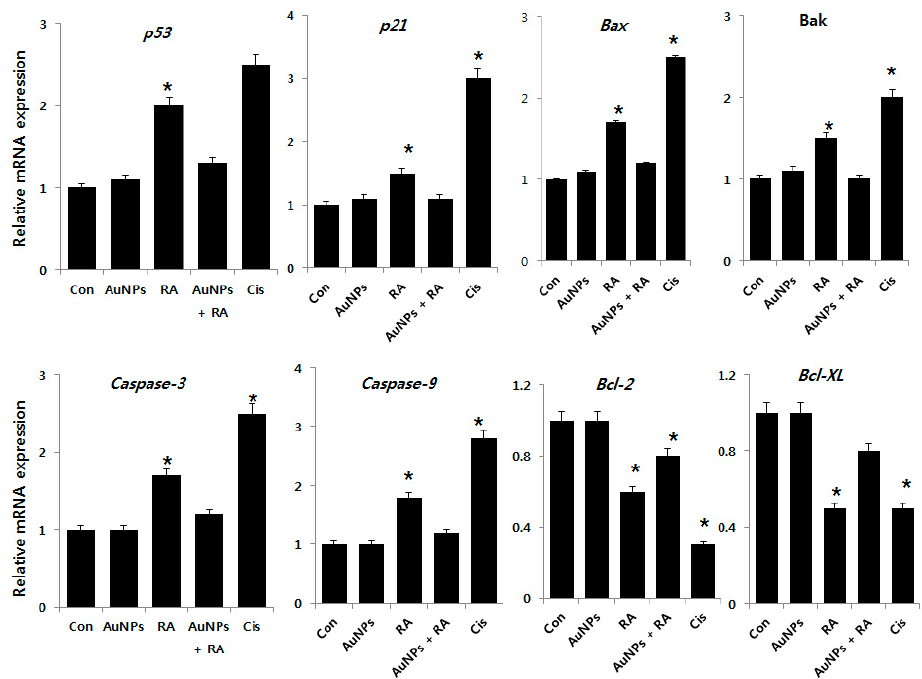
Figure 8. Effect of AuNPs on RA-induced expression of apoptotic gene expression in F9 cells.